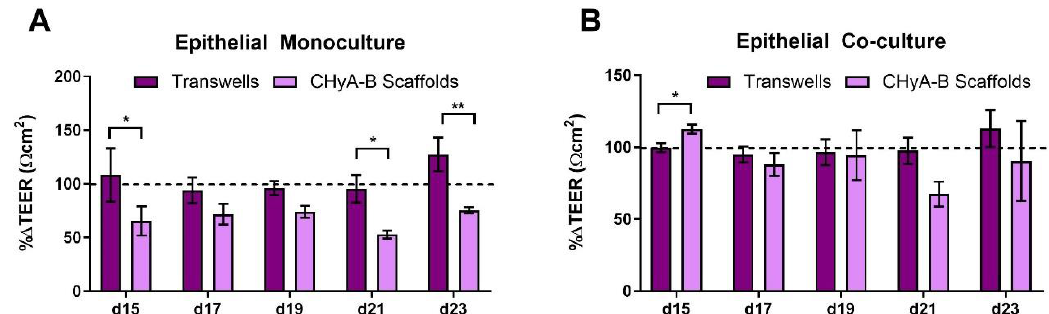
Figure 5. TEER measurements following drug-mediated challenge. TEER recovery of Calu-3 epithelial monocultures ( A ) and Calu3 Wi38 epithelial co-cultures ( B ) on Transwell ® inserts and CHyA-B scaffolds following challenge with 100 µ g/mL of bleomycin for 24 h measured at day 15, 17, 19, 21 and 23 in culture. TEER recovery values normalised to the recovery of untreated samples for each culture condition. Results displayed as mean ± SEM ( n = 3; * p < 0.05, ** p <